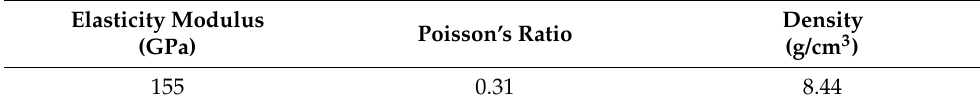
Figure 3. FE model of the rotor blade. Table 2. Material properties.